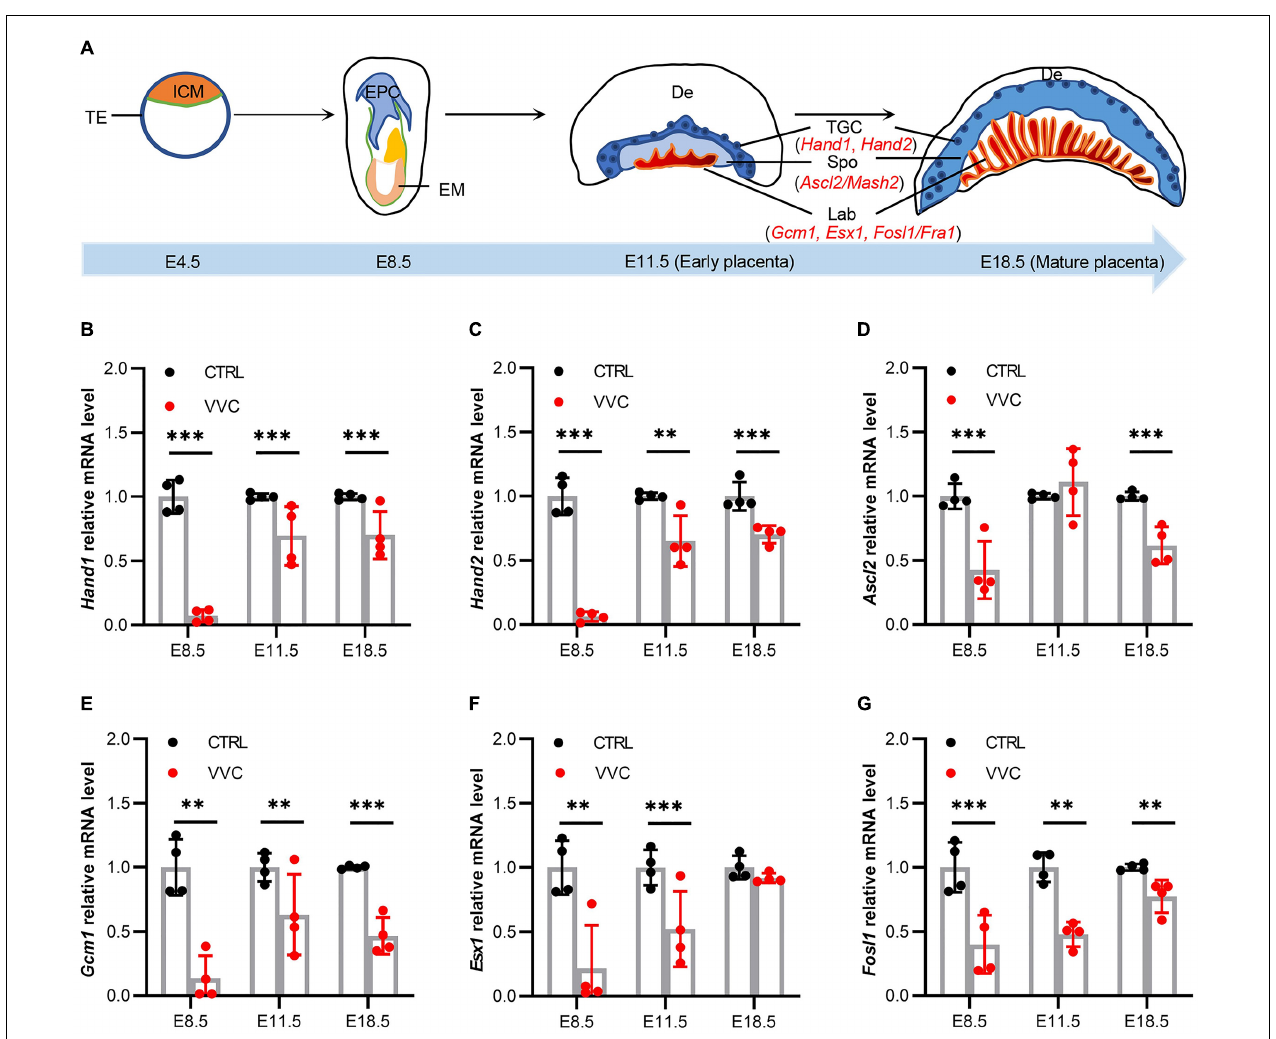
FIGURE 6 | Effects of Vaginal C. albicans infection on the expression of placental development genes. (A) The schematic diagram of mouse placenta structure. ICM, inner cell mass; TE, trophectoderm; EPC, ectoplacental cones; EM, embryo; De, decidua; TGC, trophoblast gaint cell; Spo, spongiotrophoblast; Lab, labyrinth. Hand1, heart and neural crest derivatives expressed 1; Hand2, heart and neural crest derivatives expressed 2; Ascl2, achaete-scute family bHLH transcription factor 2; Gcm1, glial cells missing homolog 1; Esx1, extraembryonic spermatogenesis homeobox 1; Fosl1, fos-like antigen 1. (B–G) Relative expression levels of Hand1 (B) , Hand2 (C) , Ascl2 (D) , Gcm1 (E) , Esx1 (F) , and Fosl1 mRNA (G) in mice placentas from the VVC group and control group at E8.5, E11.5, and E18.5. mRNA levels were quantified using reverse transcription-quantitative polymerase chain reaction (qRT-PCR) and normalized to Gapdh . Four samples of each group were used. The experiment was performed in triplicate wells and repeated three times. Data are presented as means ± SD. Unpaired t -test was used for two-group comparisons. ∗ p < 0.05, ∗∗ p < 0.01, ∗∗∗ p < 0.001 for VVC vs.